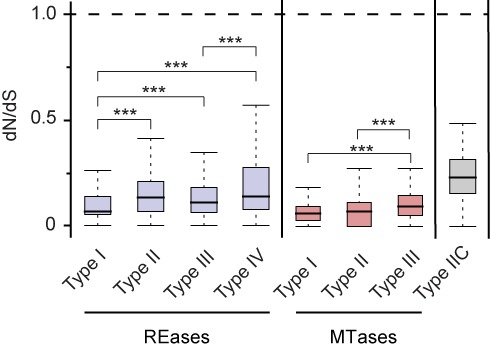
Evolution of R-M systems. Variation in dN/dS between REases, MTases and Type IIC systems. Error bars represent standard deviations. Significance was determined by computing Mann–Whitney–Wilcoxon test P values. For the sake of simplicity, we only show intra-REase and intra-MTase statistics. All remaining pairwise statistical comparisons are significant at P < 10−3 with the exception of Type I REases-Type III MTases (P < 0.05) and Type III REases-Type III MTases (P < 10−2). ***P < 10−3.